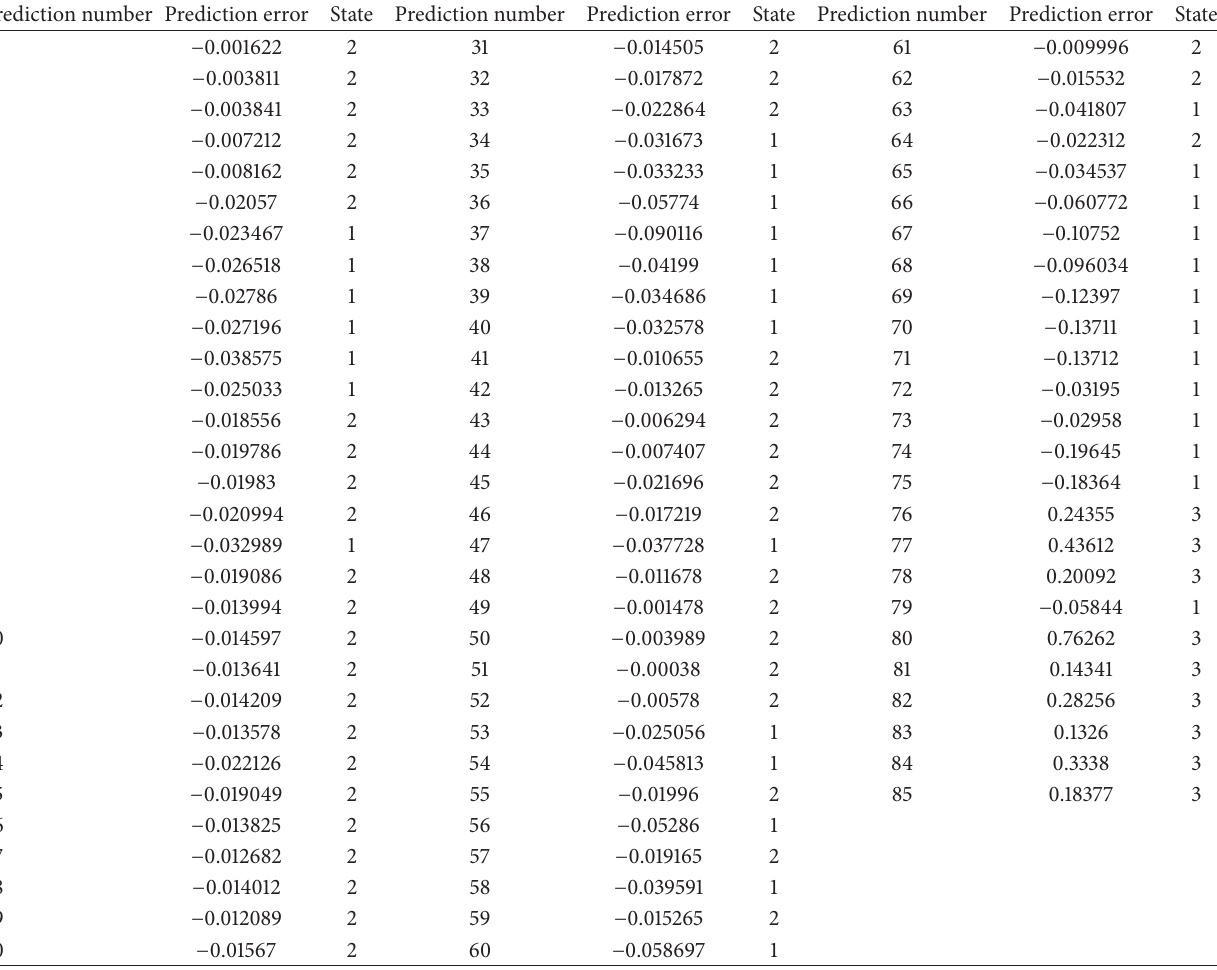
Table 2: The result of the state division and the prediction results.